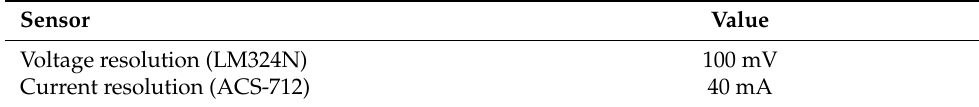
Table 2. Voltage and current measurment accurancies.